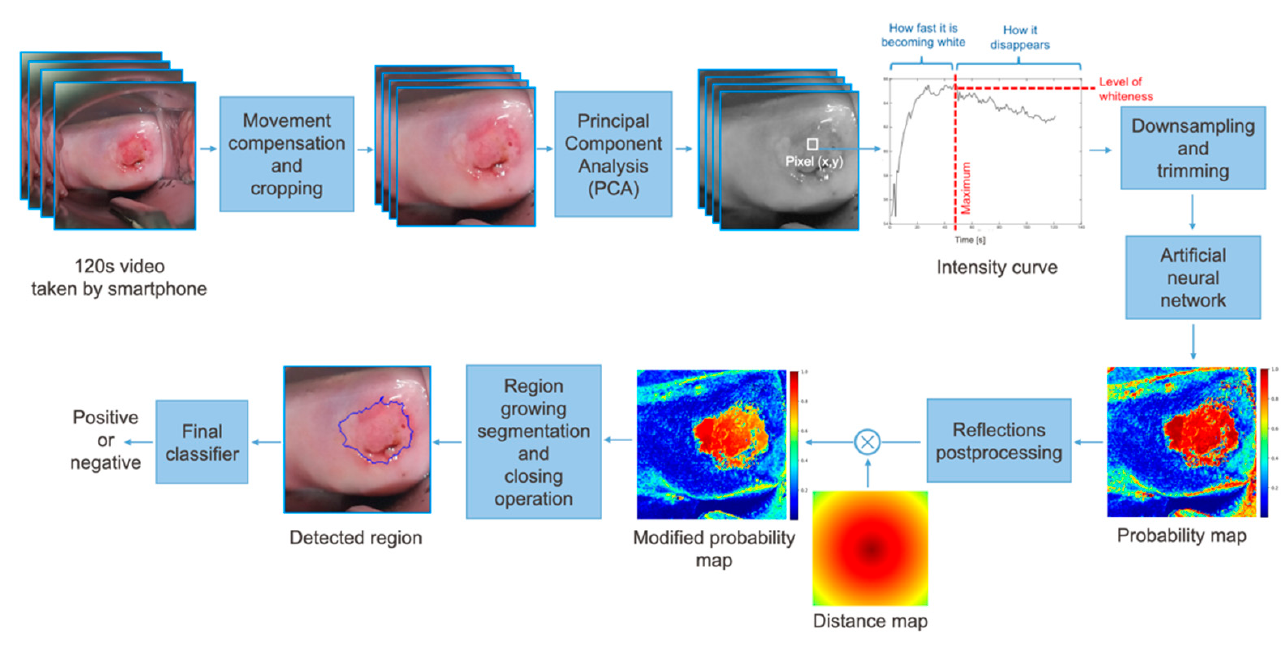
Figure 2. Pipeline of the proposed approach. The features mentioned on the intensity curve, such as how fast it is becoming fast and level of whiteness, are only human interpretation of the curves and are not pre-computed; the proposed network only uses the raw data at its input.